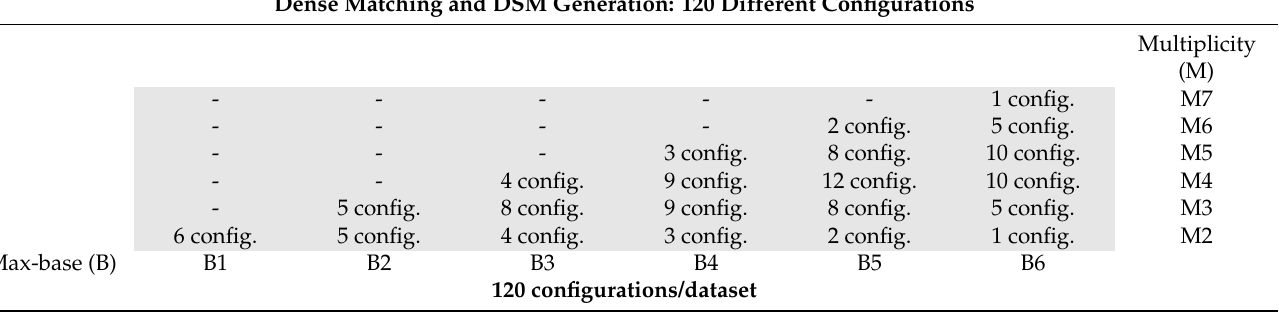
Table 1. The table summarizes the number of image configurations provided by each pair of max-base and multiplicity